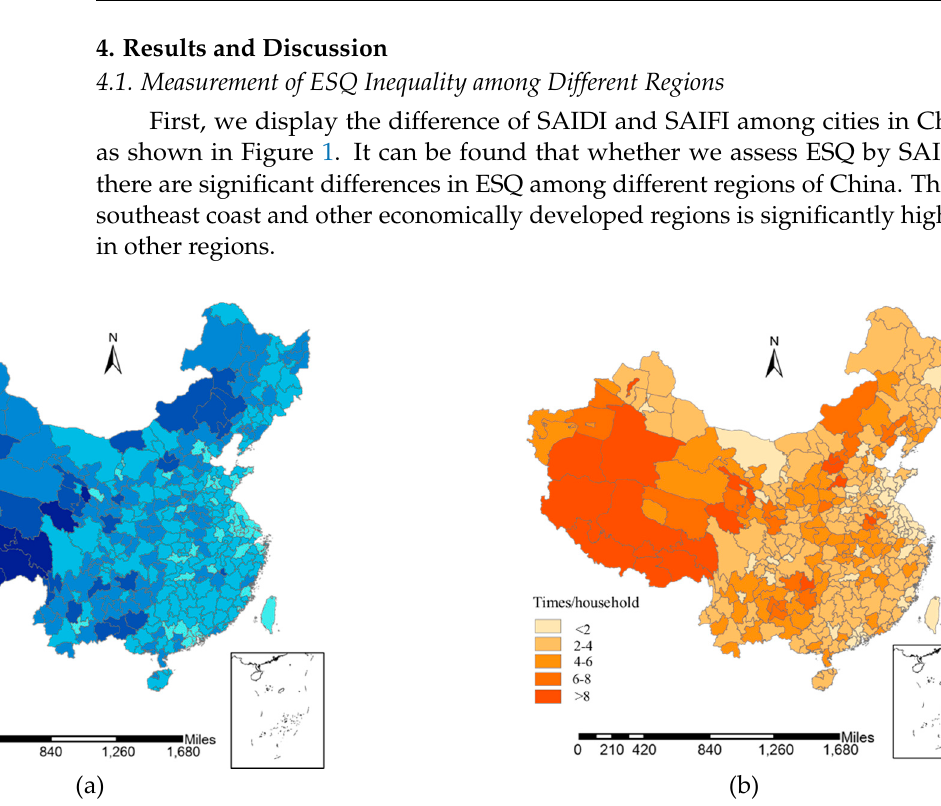
Figure 1. ( a ) Distribution of SAIDI in China. ( b ) Distribution of SAIFI in China. Different ranks in the distribution maps are mainly based on the actual data and referenced by the planning of government’s requirements on the reliability of power grid over the years, for example, during the 11th five-year plan, the State Grid Corporation of China (SGCC) promised to promote the reliability rate of rural ESQ to